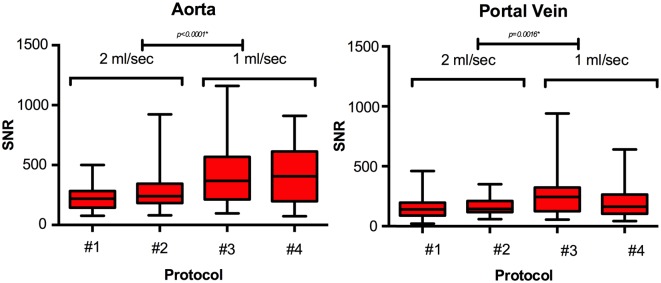
Arterial phase SNR in the aorta (left) and in the portal vein (right), comparison of different contrast agent application protocols (#1–4).SNR in the aorta and portal vein were significantly higher in protocol groups using the slower injection rate of 1 ml/sec, as compared to an injection rate of 2 ml/sec (p<0.0001 and p = 0.0016). * indicates a statistical significance.